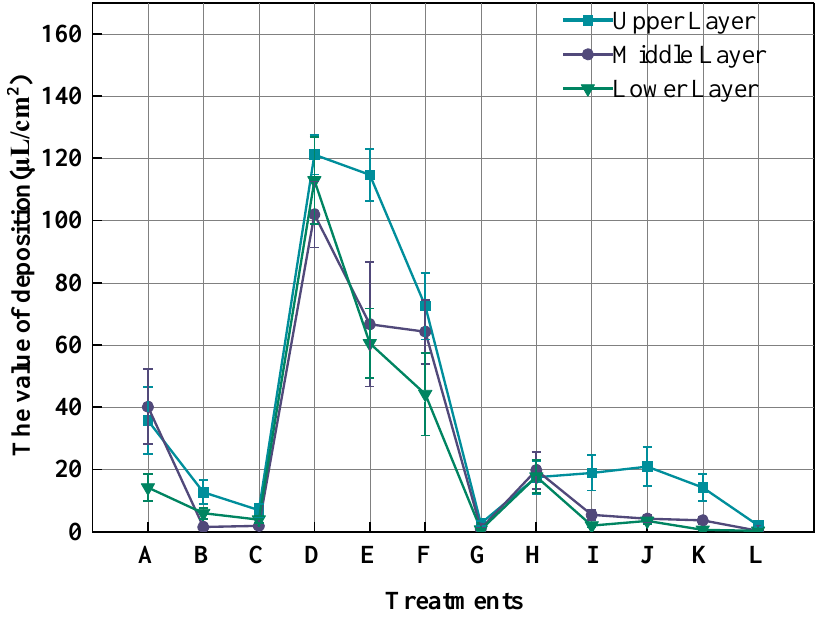
Figure 11. Average droplet deposition in different rice canopy under different experimental treat- ments.